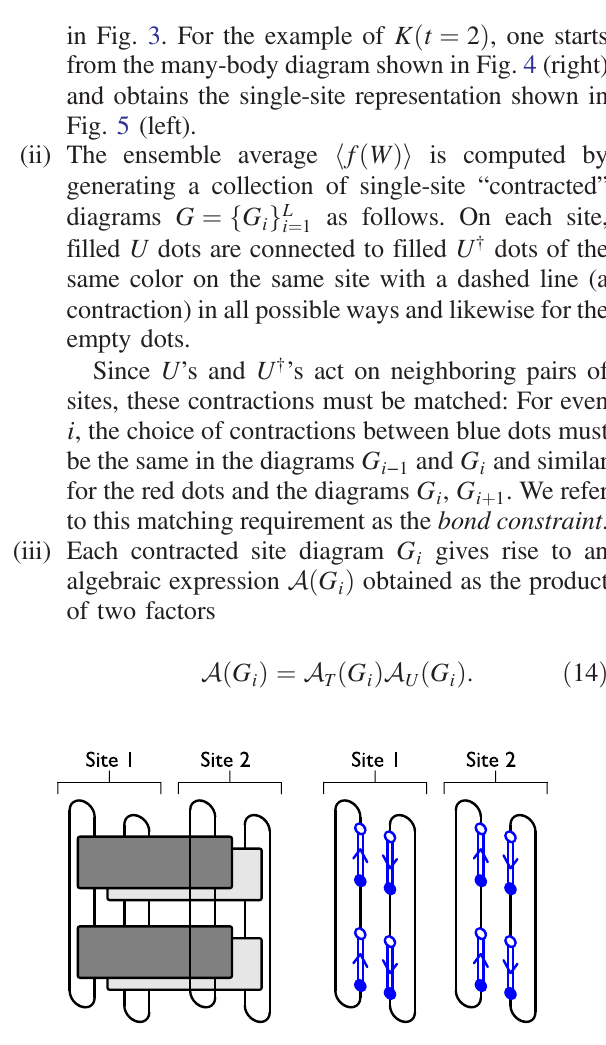
FIG. 4. Alternative diagrammatic representations of Tr ½ W ð t ¼ 2 Þ(cid:2) Tr ½ W † ð t ¼ 2 Þ(cid:2) , which gives K ð t ¼ 2 Þ after ensem- ble averaging using the notation of the left and right sides of Fig. 3.